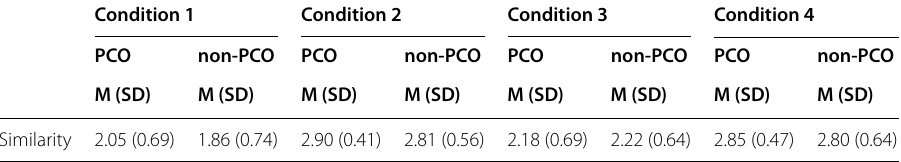
Values for similarity are the natural logarithm of the sum of participants’ responses